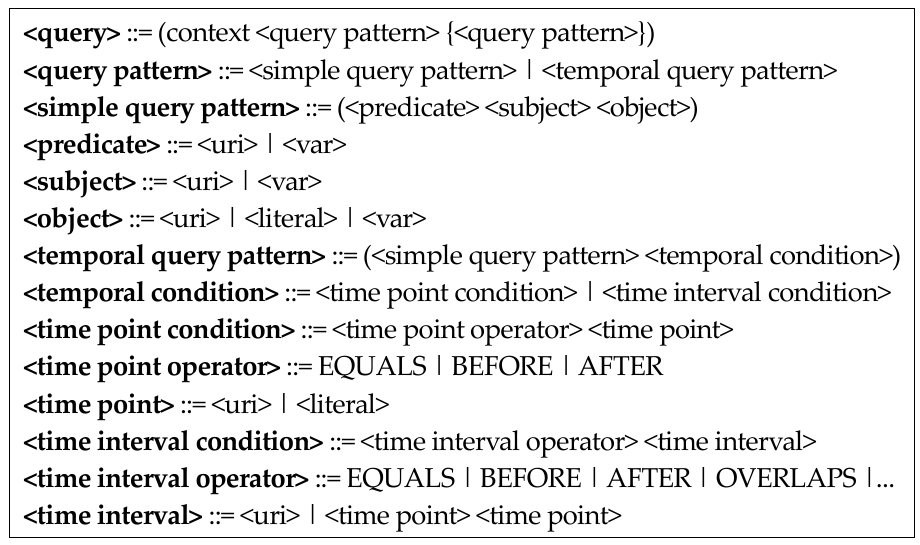
Figure 7. Grammar structure of the context query language.